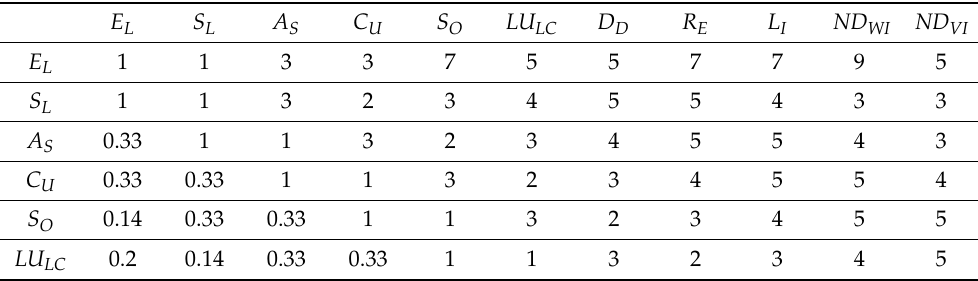
Table 4. Pairwise comparison